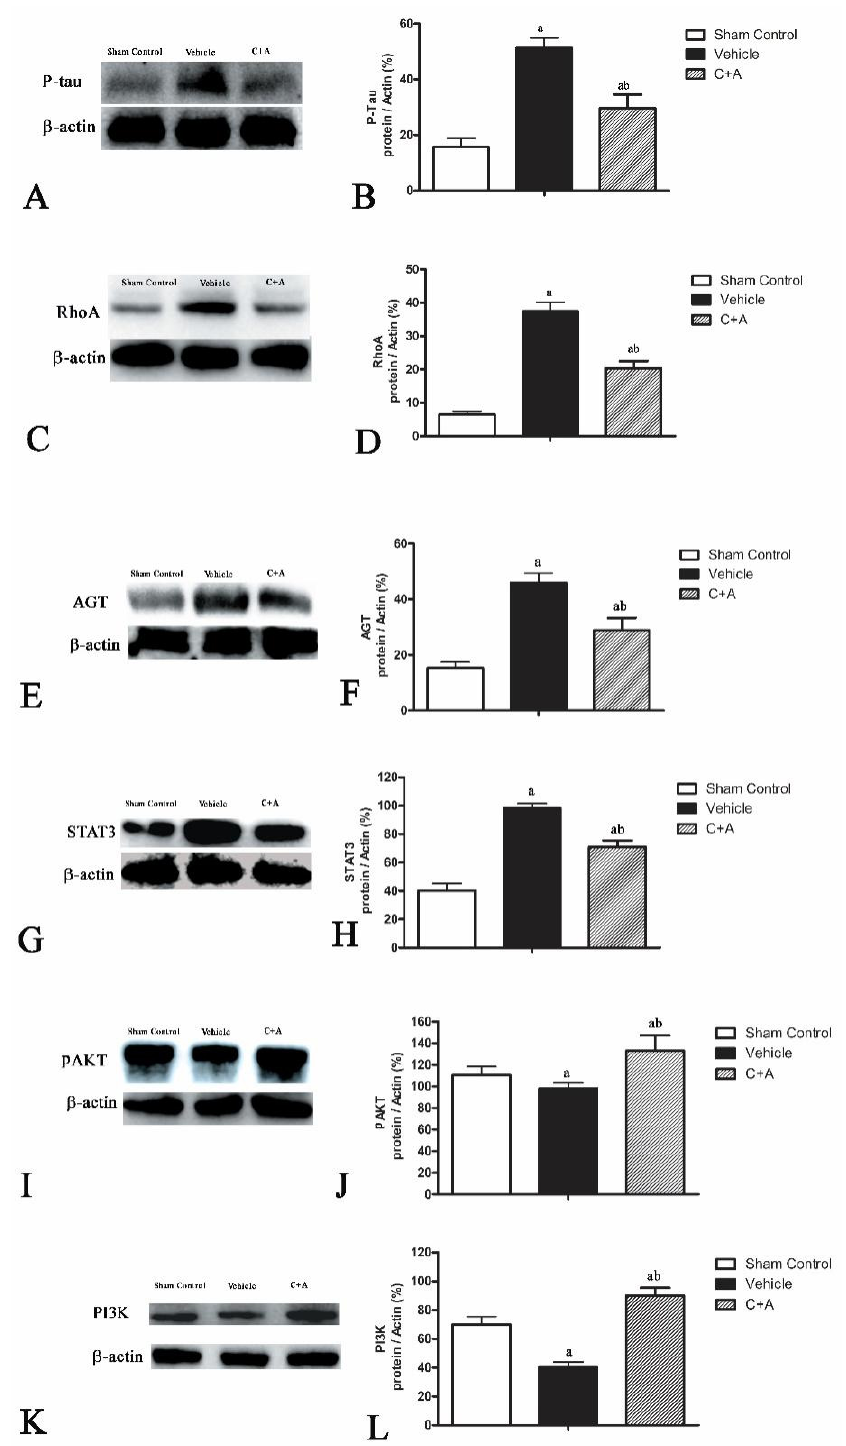
Figure 12. Western blot analysis of the level of ( A , B ) phosphorylated tau (p-tau), ( C , D ) RhoA/Rho kinase, ( E , F ) angiotensinogen (AGT), ( G , H ) signal transducers and activators of transcription 3 (STAT), ( I , J ) phosphorylated AKT (p-AKT), and ( K , L ) phospho-Tyr467 (PI3K/P85) in all groups. ( B , D , F , H , J , L ) Semi-quantitative profiles of protein bands showed that treatment with C16 plus Ang-1 suppressed the upregulation of p-tau, RhoA, AGT, and STAT3 in AD rats, but increased the expression of p-AKT and PI3K. a, p < 0.05 vs. sham control group; b, p < 0.05 vs. vehicle group. Molecular weight (MW): p-tau, 68 KD; RhoA, 22 KD; AGT, 52 KD; STAT3, 88 KD; p-AKT, 60 KD; PI3K, 85 KD; β -actin, 42 KD.